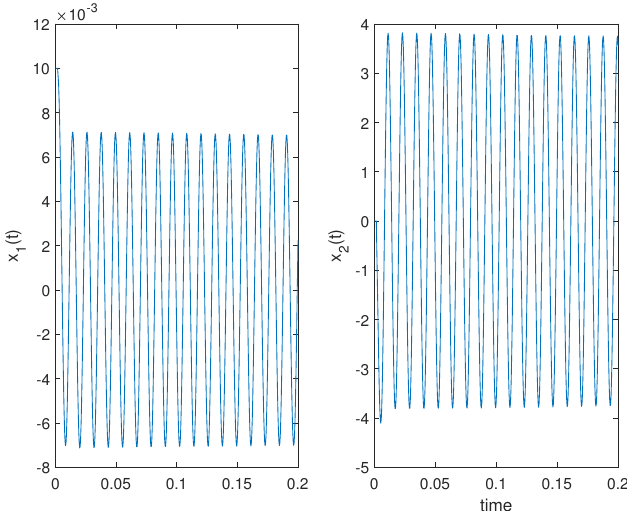
Figure 6. State trajectories of the state vector X ( t ) of Case